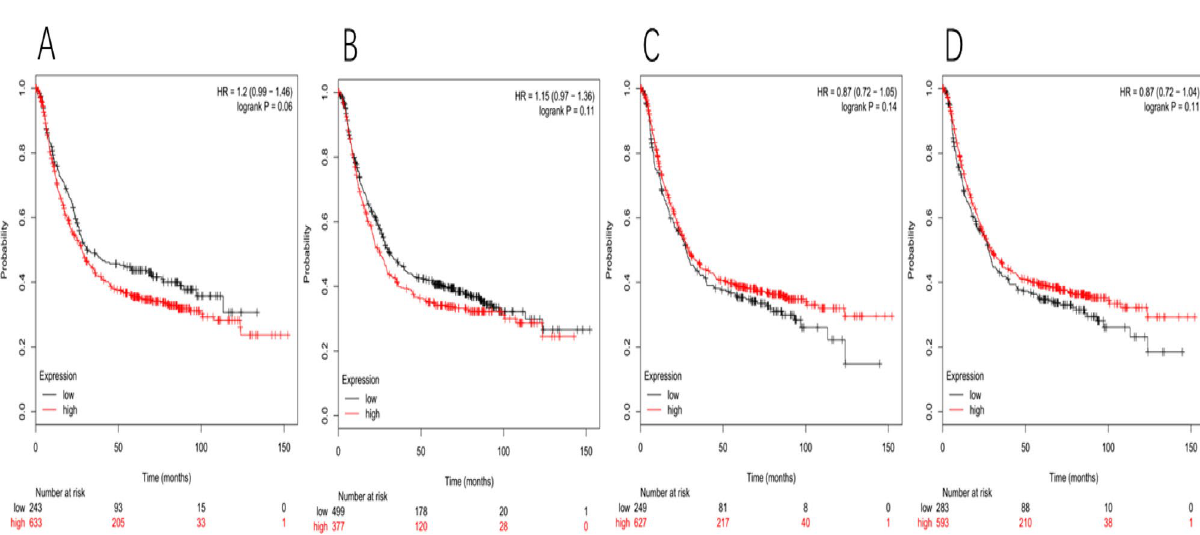
Figure 2. For DLL4, The Affymetrix ID is: 223525_at. ( A ) OS curves are plotted for GC patients (n = 631). For JAG2, The Affymetrix ID is: 209784_s_at. ( B ) OS curves are plotted for GC patients (n = 876). The Affymetrix ID is: 32137_at. ( C ) OS curves are plotted for GC patients (n = 876).